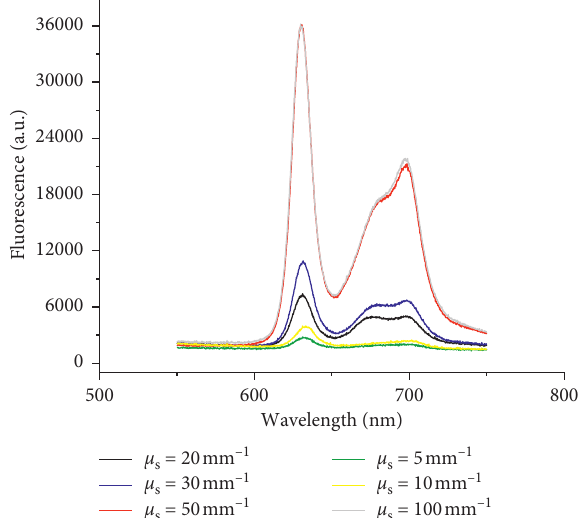
Figure 2: Recordings of fluorescence spectra for different values of scattering coefficient.